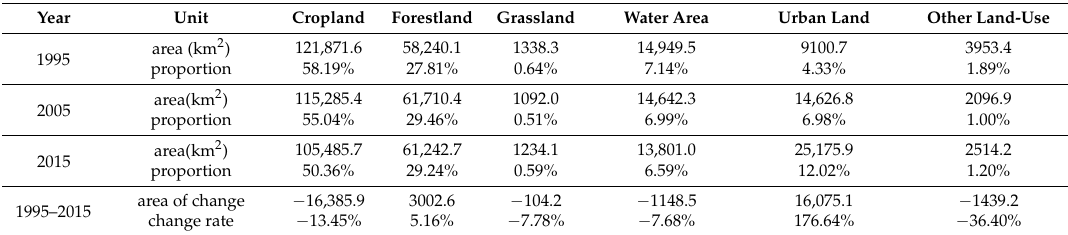
Table 4. Areas and proportions of six land-use types in the Yangtze River Delta Urban Agglomeration (YRDUA) in 1995, 2005, and 2015. Change rates refer to the ratio of their area change during 1995–2015 to the original area in